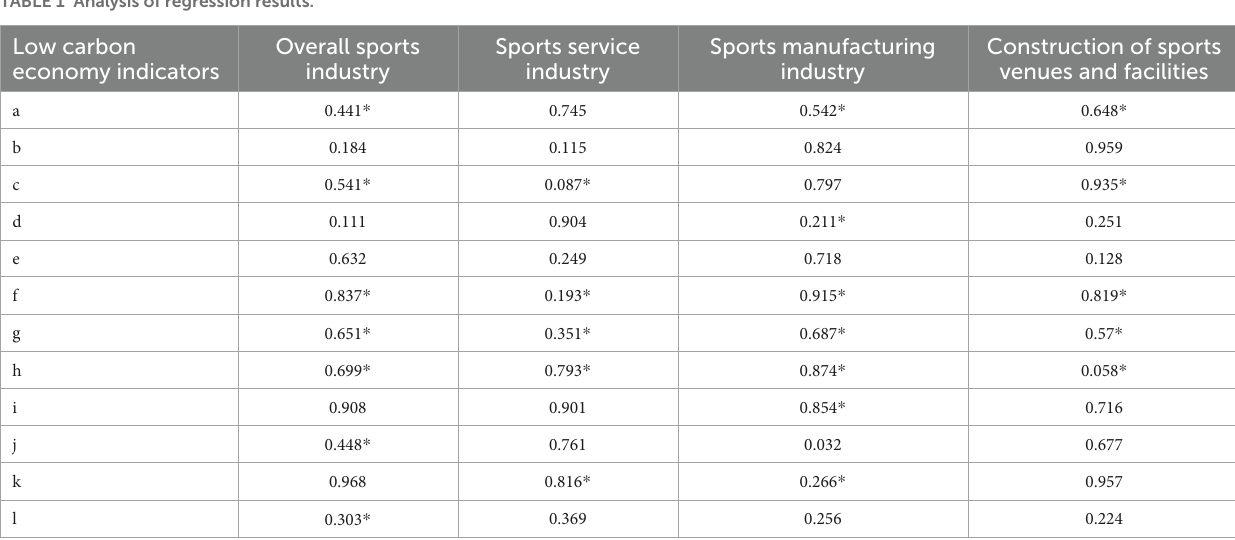
TABLE 1 Analysis of regression